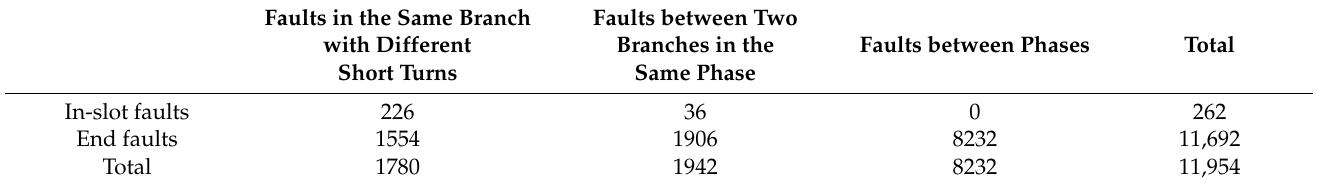
Table 5. The actionable protection number statistical results when both methods are